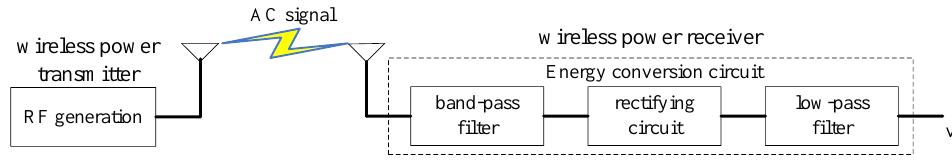
Figure 3. Wireless power transfer